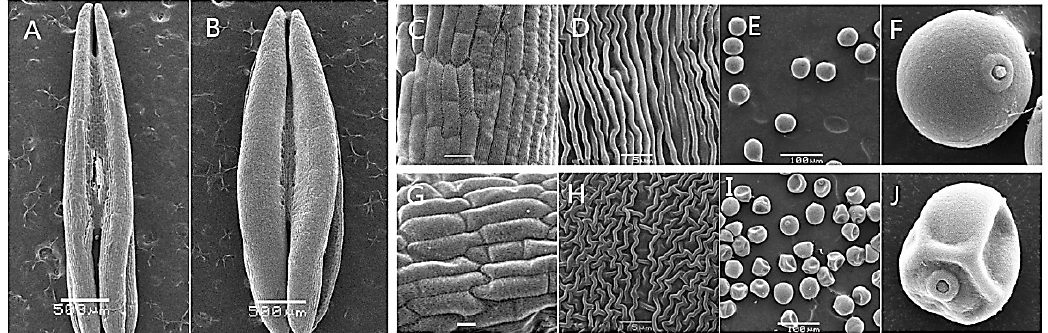
Figure 2. Comparison of scanning electron micrographs of AF ( B – F ) and AS ( A , G – J ). ( C , D , G , H ) outer epidermal ells; ( E , F , I , J ) trinucleate cells. Scale bars are 500 μ m in ( A , B ); 100 μ m in ( C , E , G , I ); 5 μ m in ( D , H ); and 30 μ m in ( F , J ).